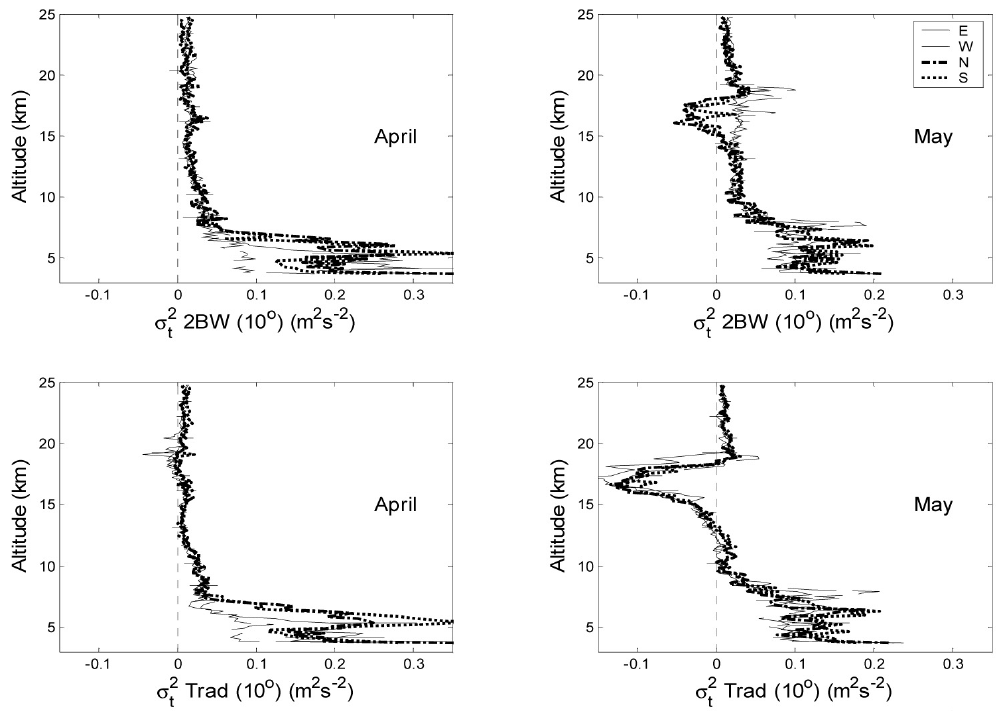
Fig. 3. Median (upper) σ 2 t -2BW and (lower) σ 2 t -Trad over all observations taken at 10 ◦ zenith angle during (left) April and (right) May. √ Bars extending ± 2 σ/ N o are entered at representative heights along the E and N